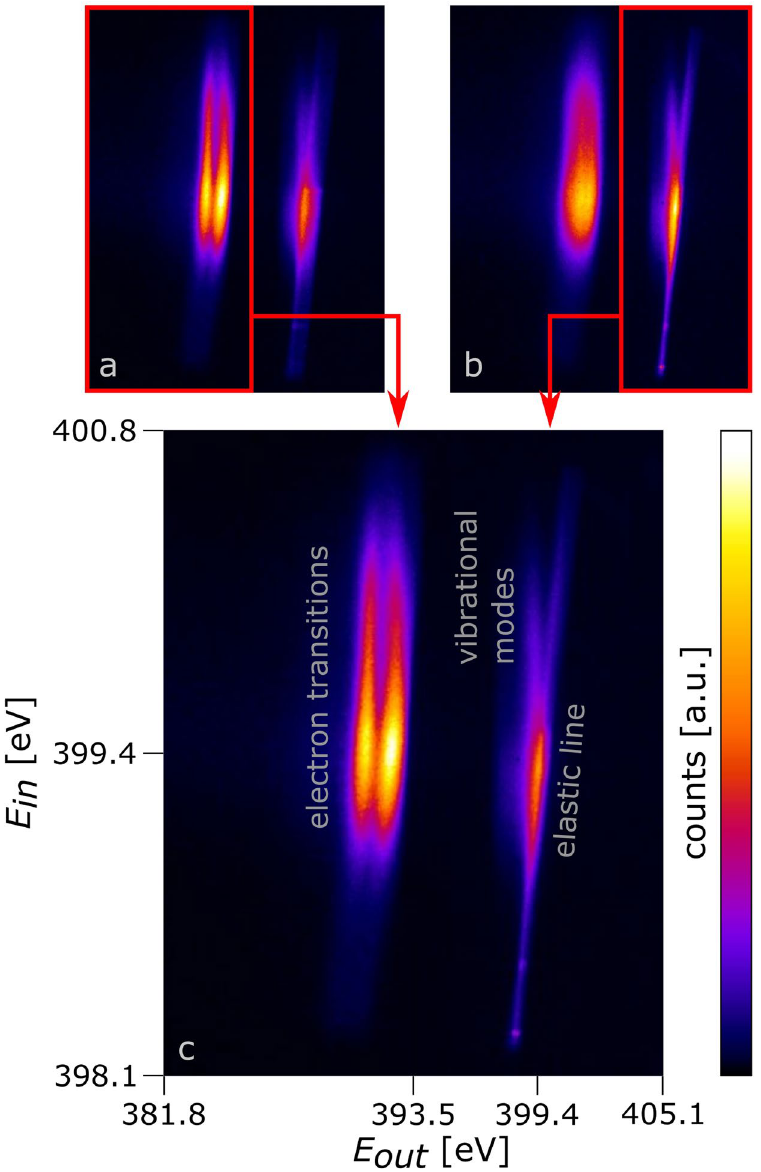
Figure 2. RIXS maps of acetonitrile in a liquid jet experiment at P04, PETRA III, recorded using an off-axis transmission FZP, incident energy 398.2 eV–400.6 eV (elastic line), focus size on liquid jet 10 μ m × 1000 μ m (h × v). Image ( c ) is a combination of image ( a ), taken at 1.00 m detector distance and image ( b) , taken at 1.12 m detector distance. ( a ) and ( b ) are the sum of 4 exposures with 240 s exposure time each. Between the exposures, the position of the line focus with respect to the liquid jet was moved in steps of 10 μ m to account for slight angular misalignments between the line focus and the